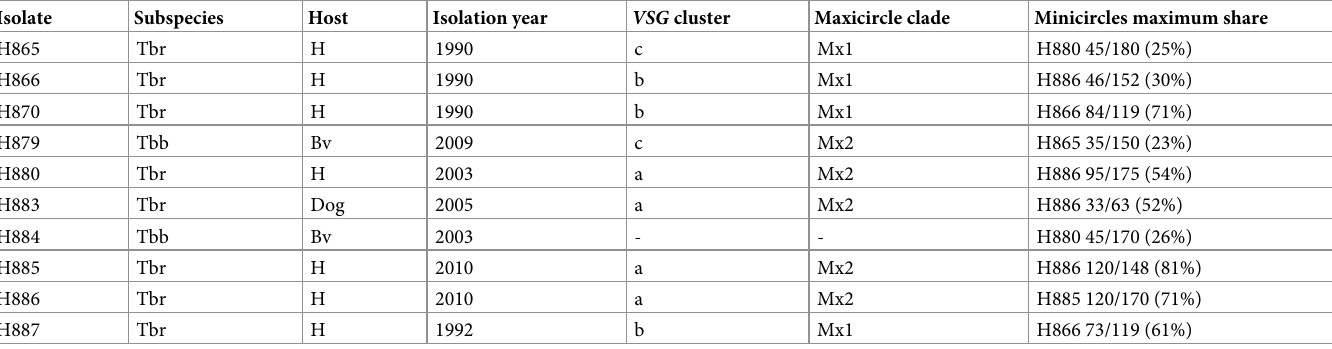
Table 4. VSG and kinetoplast DNA profiles of ten Ugandan isolates.